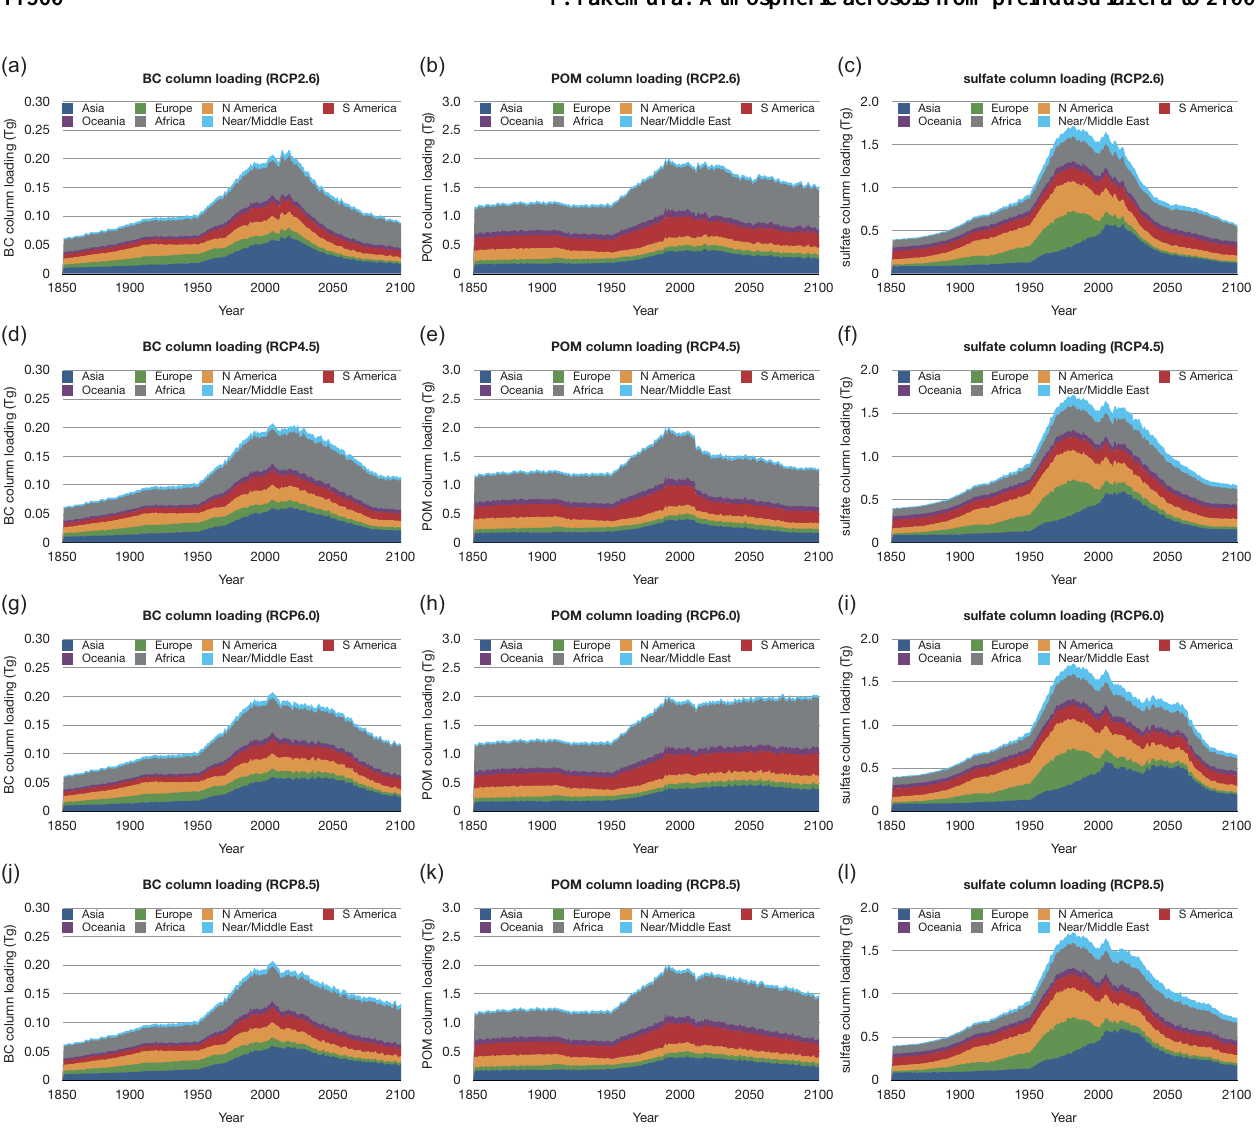
Fig. 4. Time series of regional total mass column loadings of (left) BC, (middle) POM, and (right) sulphate for (top to bottom) RCP2.6, 4.5, 6.0, and 8.5 simulated by SPRINTARS. Blue: Asia, green: Europe, orange: North America, red: South America, purple: Oceania, grey: Africa, light blue: Near and Middle